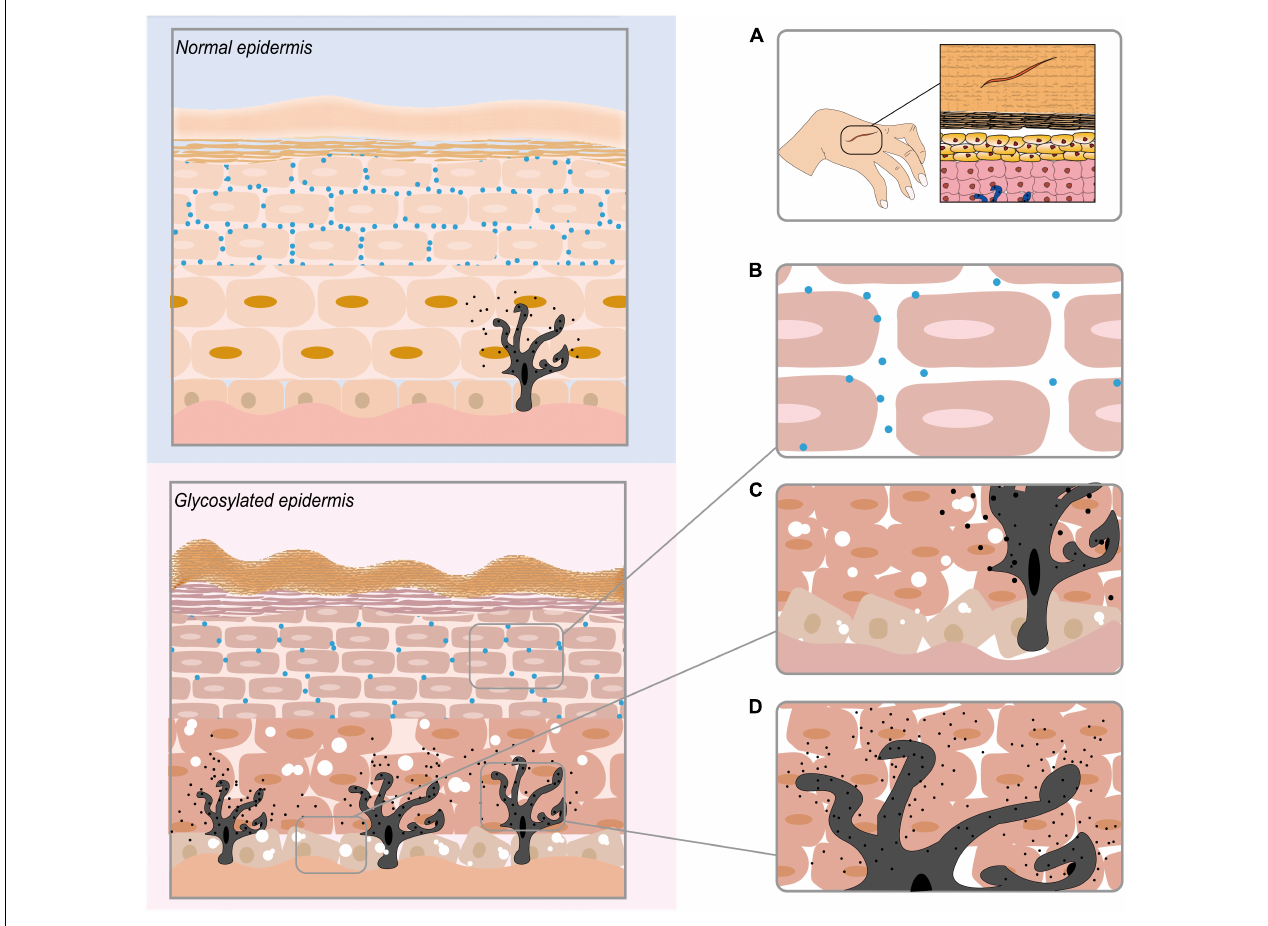
FIGURE 3 | The effect of AGEs on the epidermis of the skin. (A) AGEs obstruct skin wound healing. (B) AGEs reduce the contents of ceramide (CER) and cholesterol (CHOL) in the epidermis, eventually leading to a reduction in skin lipid content. (C) AGEs destroy the keratinocyte cell structure in the epidermis. (D) AGEs promote the production of melanin in